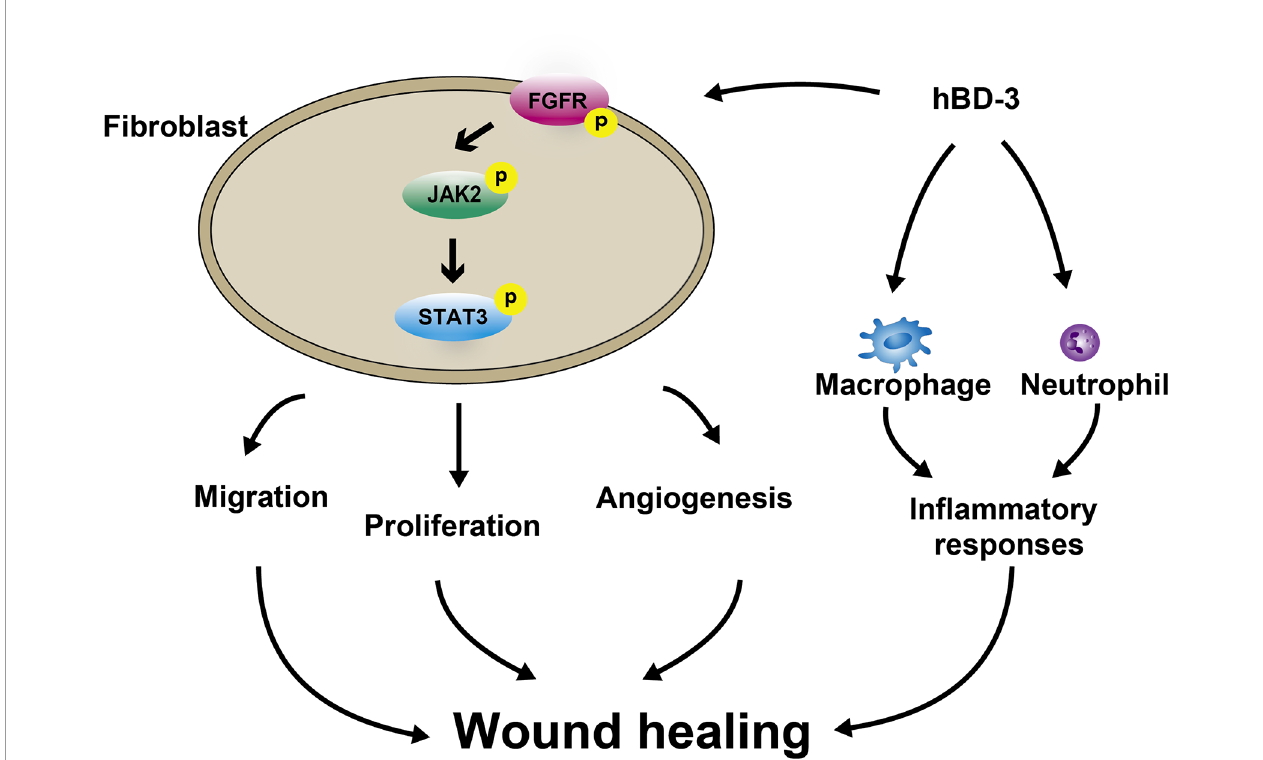
FIGURE 9 | Schematic illustrating how hBD-3 is involved in wound healing. hBD-3 induces accumulation of neutrophils and macrophages in the early phase of wound healing and reduction of these phagocytes in the latter phase, leading to regulation of in fl ammatory responses during the wound healing process. hBD-3 also stimulates fi broblasts to migrate, proliferate and promote angiogenesis via activation FGFR/JAK2/STAT3